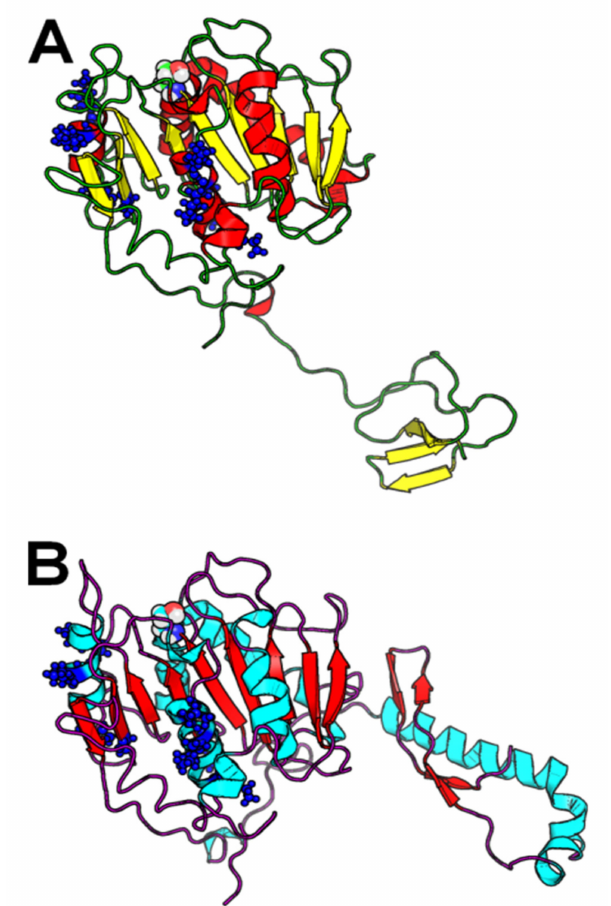
Figure 2. Lysine residues on the Thc_Cut1_CBM ( A ) and the Thc_Cut1_PBM ( B ) surface, highlighted in blue sphere mode. The catalytic serine residue (Ser131) was also highlighted in sphere mode.